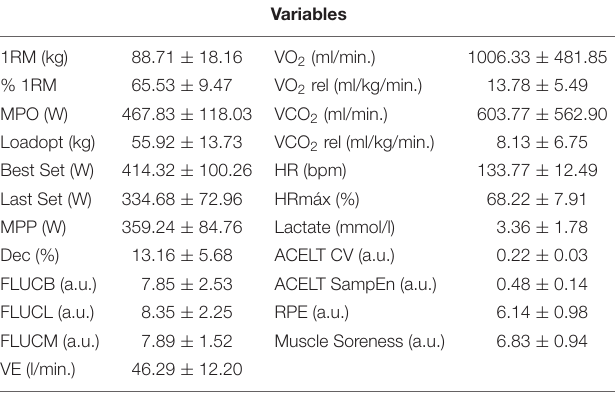
TABLE 1 | Overall results from the Parallel Back-Squat RPA protocol.